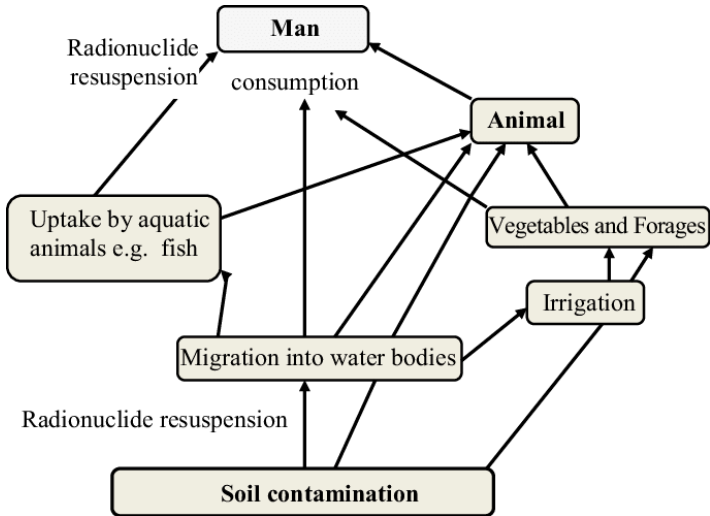
Figure 1. Radionuclide entry into the environment [67].